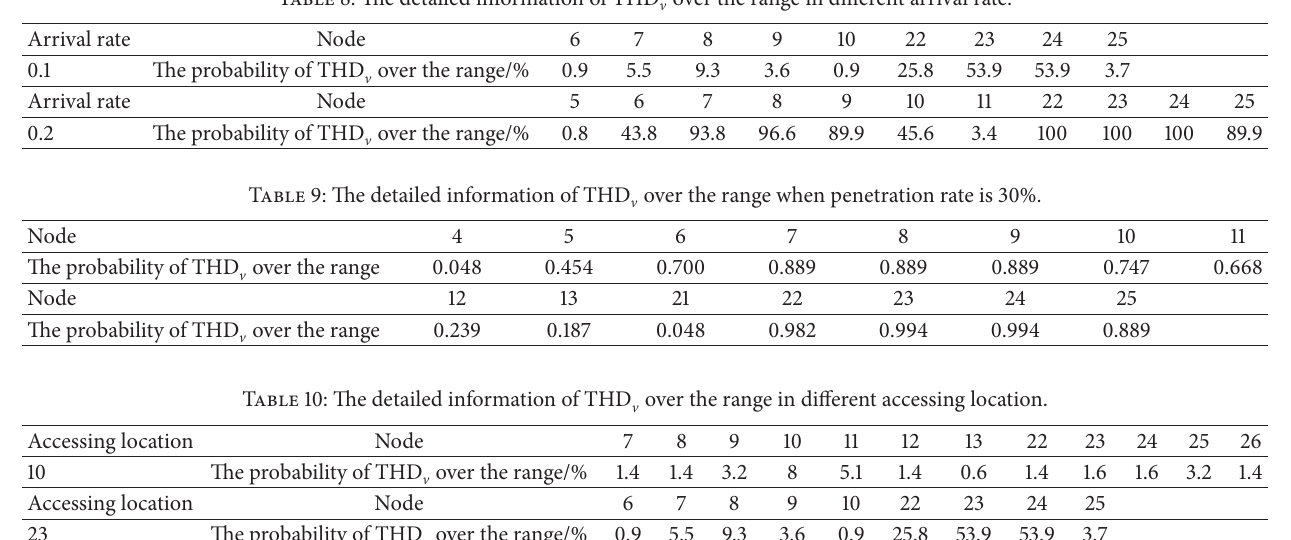
Table 8: The detailed information of THD V over the range in different arrival rate.